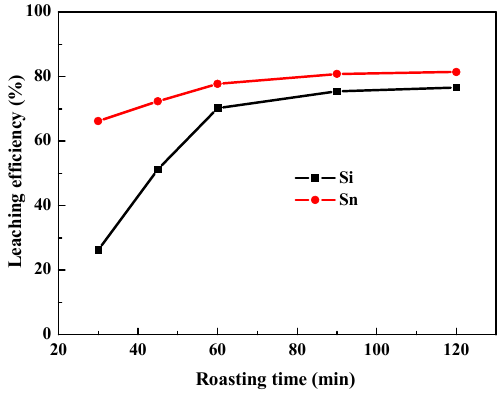
Figure 1. Effect of roasting temperature on leaching efficiency of Sn and Si (Time: 60 min). Figure 1. E ff ect of roasting temperature on leaching e ffi ciency of Sn and Si (Time: 60 min).